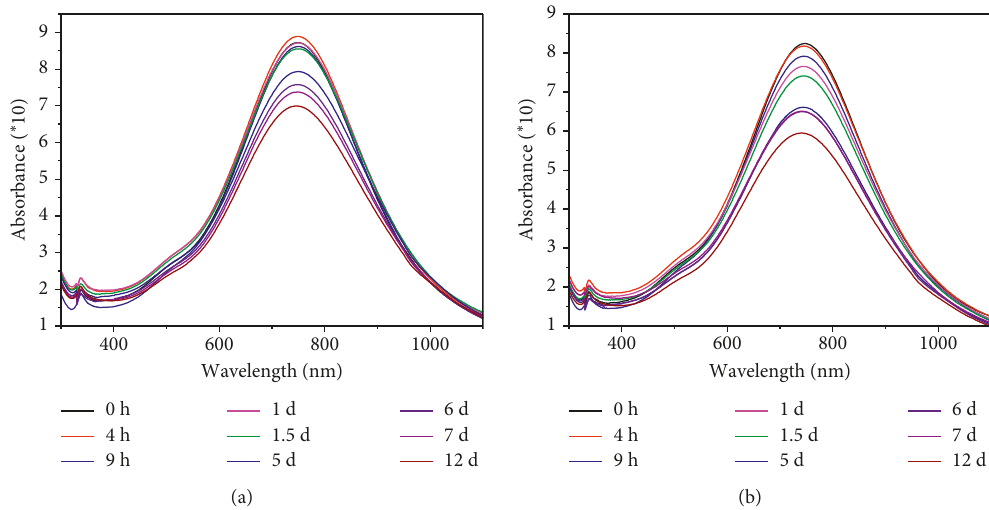
Figure 2: UV-Vis extinction spectra of Ag@Au core-shell NPs stored for a period of time in pure water (a) and PBS buffer (10mM,pH � 7.4) (b).